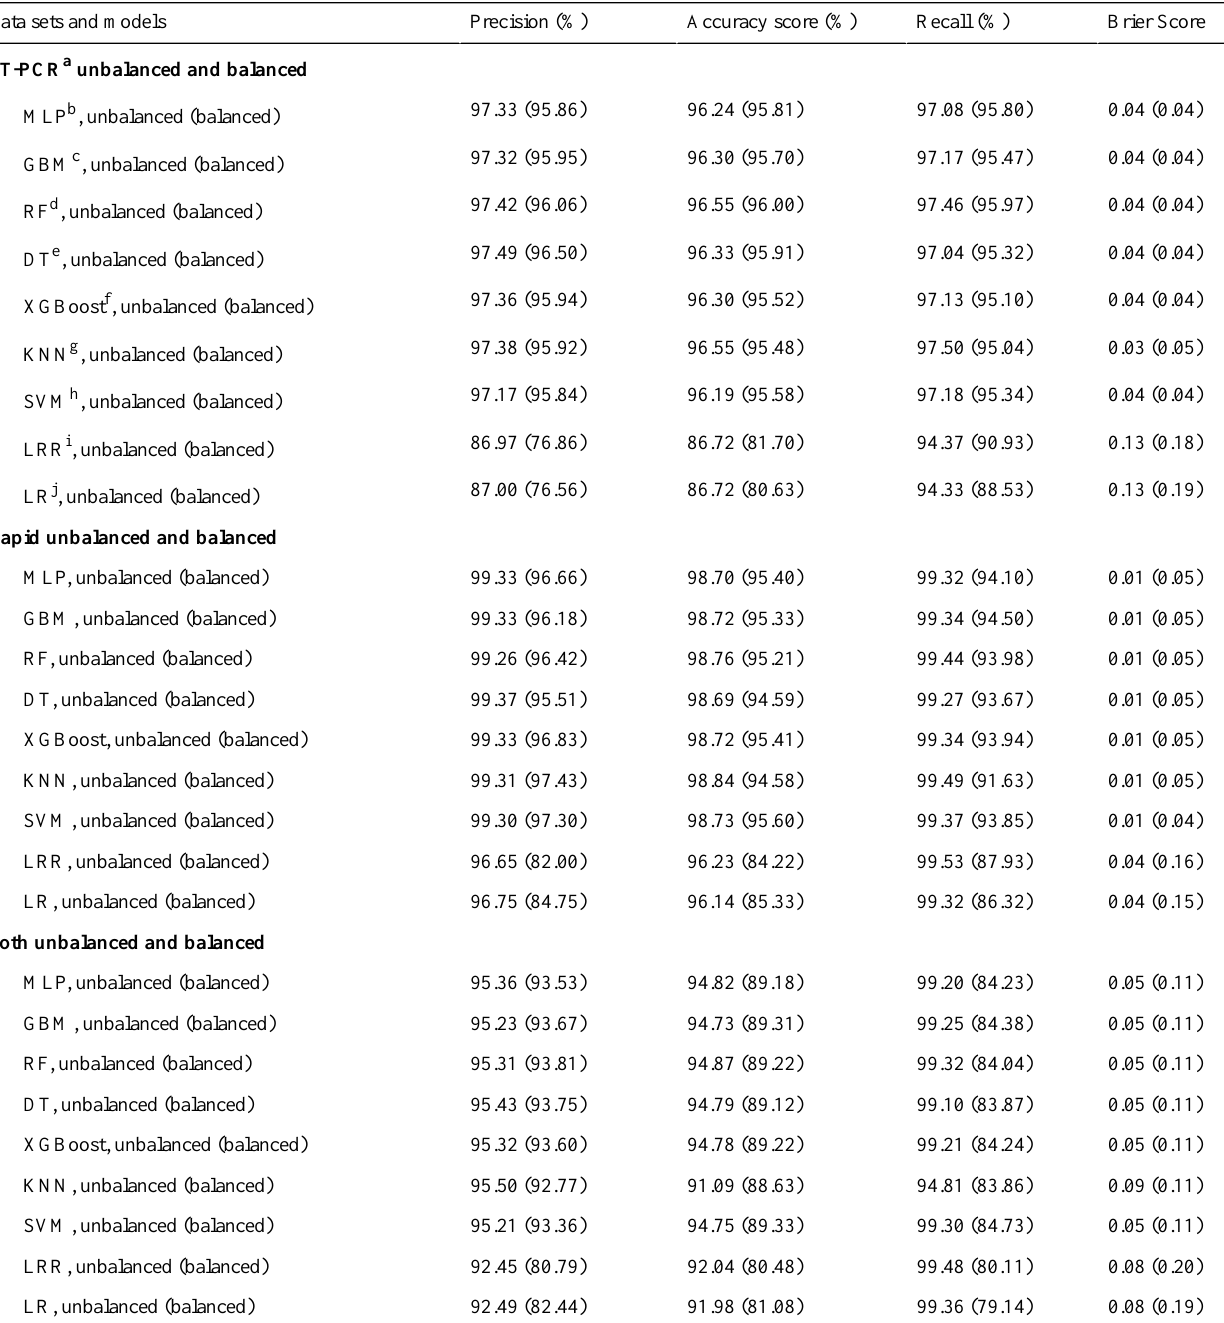
Brier ScoreRecall (%)Accuracy score (%)Precision (%)Data sets and models